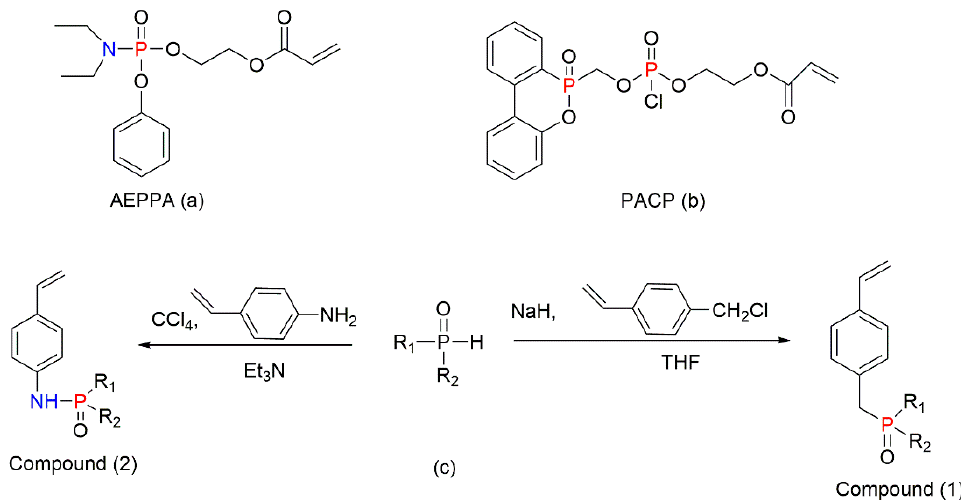
Figure 27. A chemical structure of acryloxyethylphenoxy phosphorodiethylamidate (AEPPA) ( a ) and ( b ); syntheses of styrene-based reactive FRs ( c )